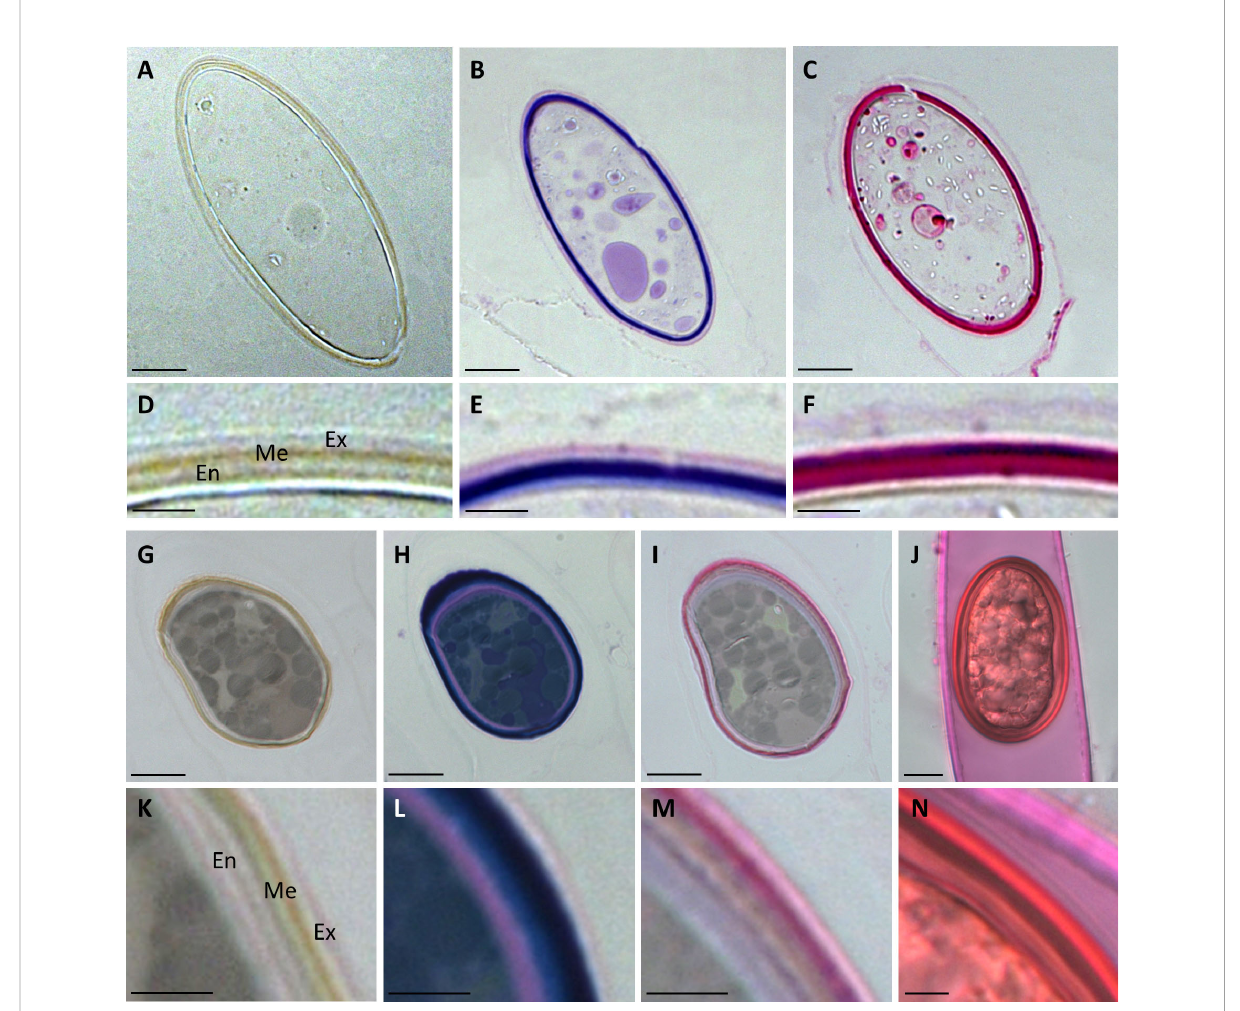
FIGURE 4 Histochemical stainings of Spirogyra zygospores. (A – F) Spirogyra sp.; (G – N) Spirogyra mirabilis . (A – C, G – I) semithin sections of HPF zygospores with (D – F, K – M) corresponding detail view of a cell wall section; (J) un fi xed fi eld sampled zygospore inside the female gametangium with (N) corresponding detail view of a cell wall section. (A, D, G, K) unstained sample; (B, E, H, L) toluidine blue staining: (C, F, I, J, M, N) ruthenium red staining. Me mesospore; En endospore; Ex exospore. Scale bars (A – C, G – J) 10 µm; (D – F, K – N) 2.5